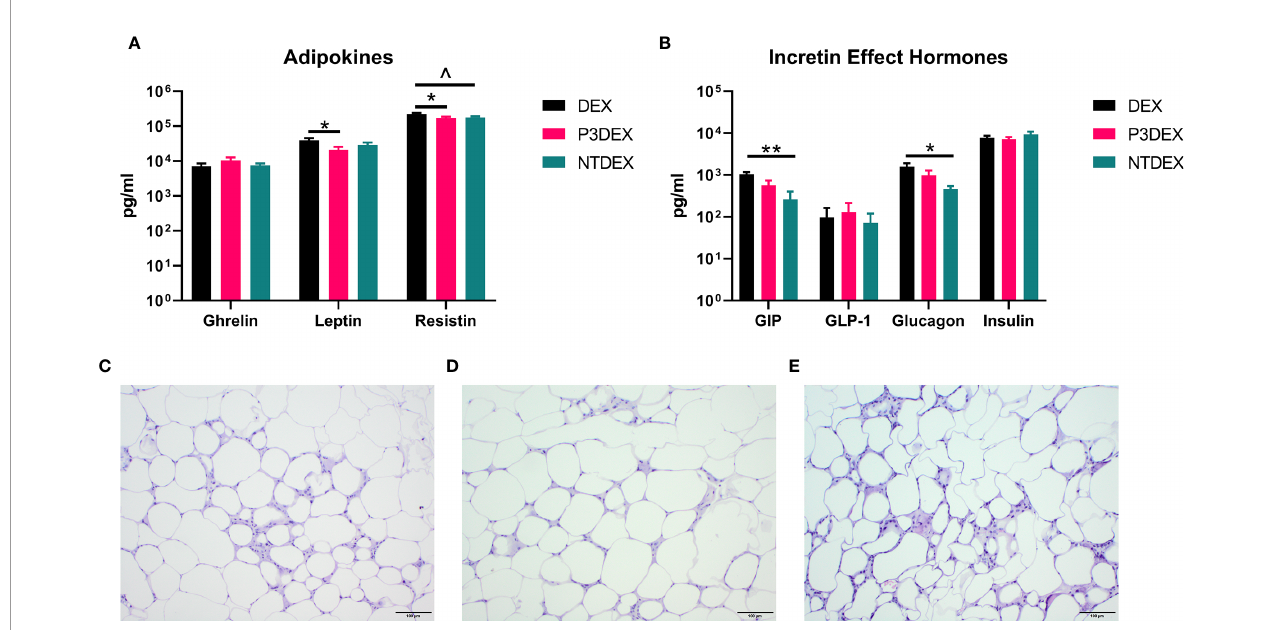
FIGURE 5 | LNFPIII conjugates reduce adipokines and WAT in fl ammation, while LNnT conjugates alter incretin effect hormones. Measurement of (A) adipokines and (B) incretin effect hormones in DIO mice treated with DEX, P3DEX, or NTDEX. One-way ANOVA with Dunnett ’ s Multiple Comparisons Test. *indicates a signi fi cant difference (*p ≤ 0.05, **p ≤ 0.01). ^indicates a trend (p ≤ 0.10). Histological analysis of vWAT depots from DIO mice treated with (C) DEX, (D) P3DEX, or (E)